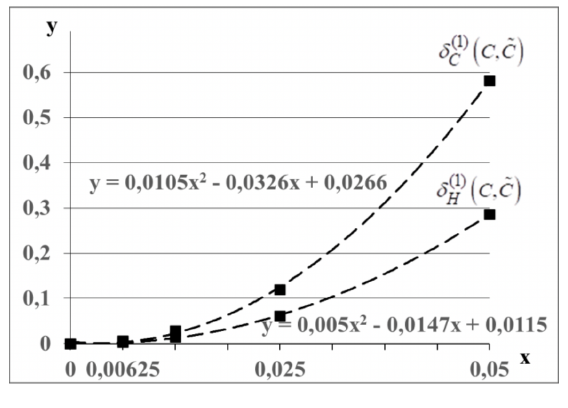
( C ) , δ (1) ( C ) , - - - graphs of H C